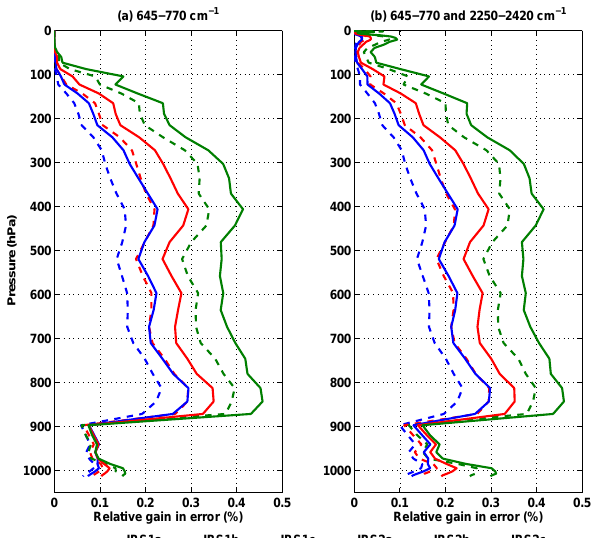
Figure 5. Impact of spectral resolution and radiometric noise on the retrieval of temperature profile based on the use of the 645– 770cm − 1 spectral band (a) or of the 645–770 and 2250–2420cm − 1 spectral bands combined (b) . The relative gain in error is defined as the difference between the a priori and a posteriori error, divided by the a priori error, averaged over the whole tropical TIGR